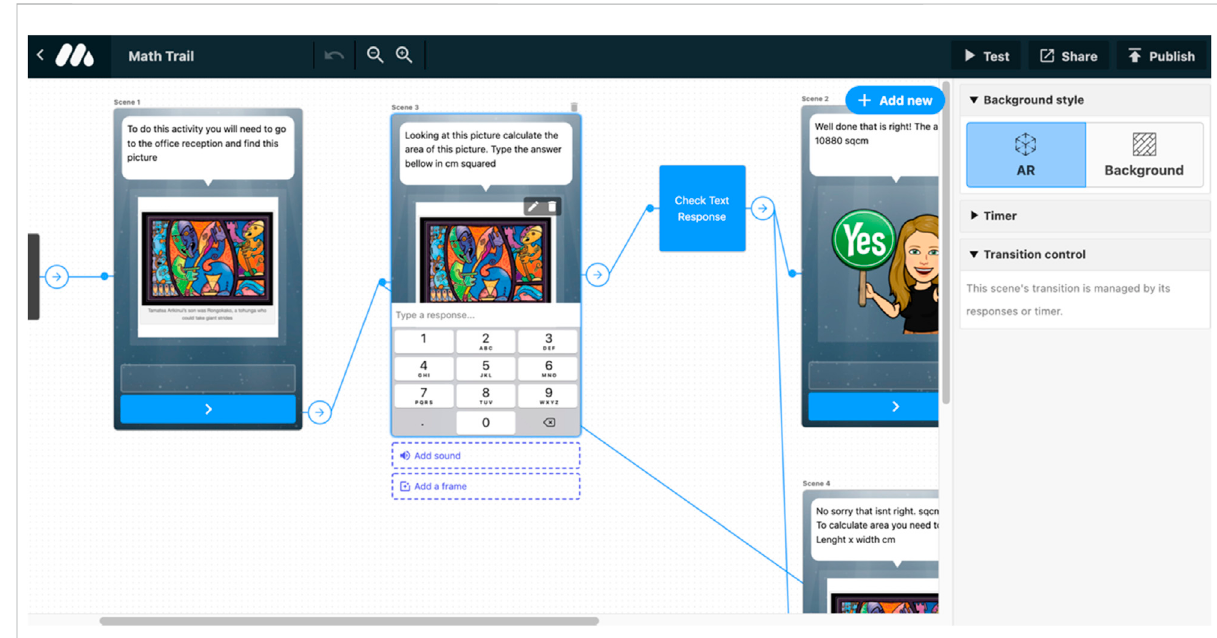
FIGURE 1 The Metaverse Studio that students used to create the AR application. The tool can be used to scaffold simple computational concepts such as fl owcharts and algorithms.